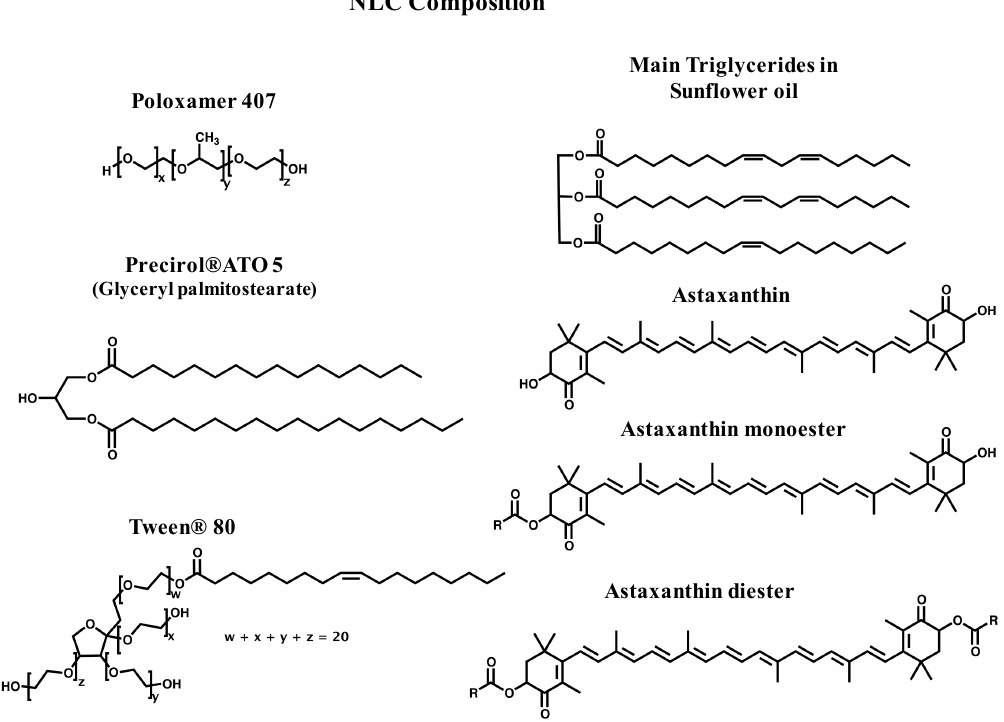
Figure 3. Chemical structures of all components of AstaCO 2 -NLC formulations.